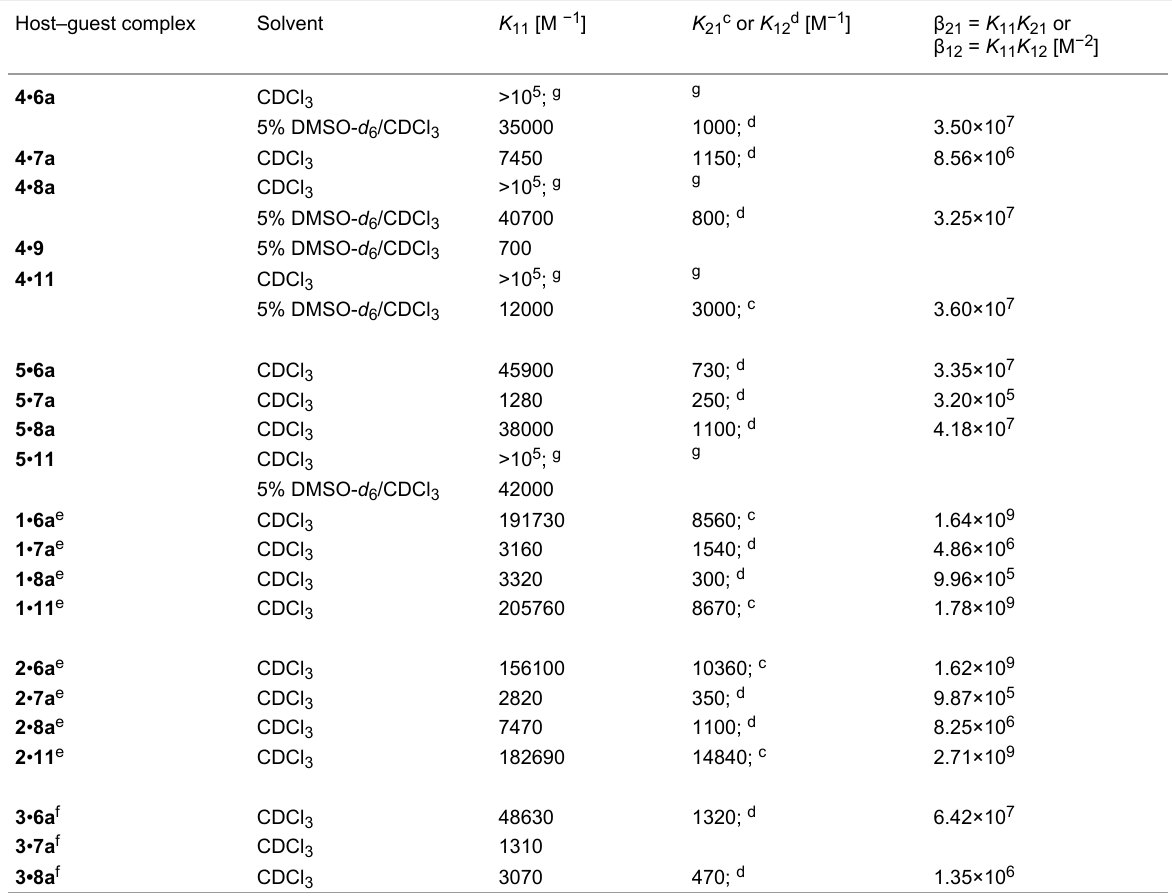
Table 3: Association constants a,b for receptors 1 – 6 and carbohydrates 6a , 7a , 8a , 9 and 11 . Host–guest